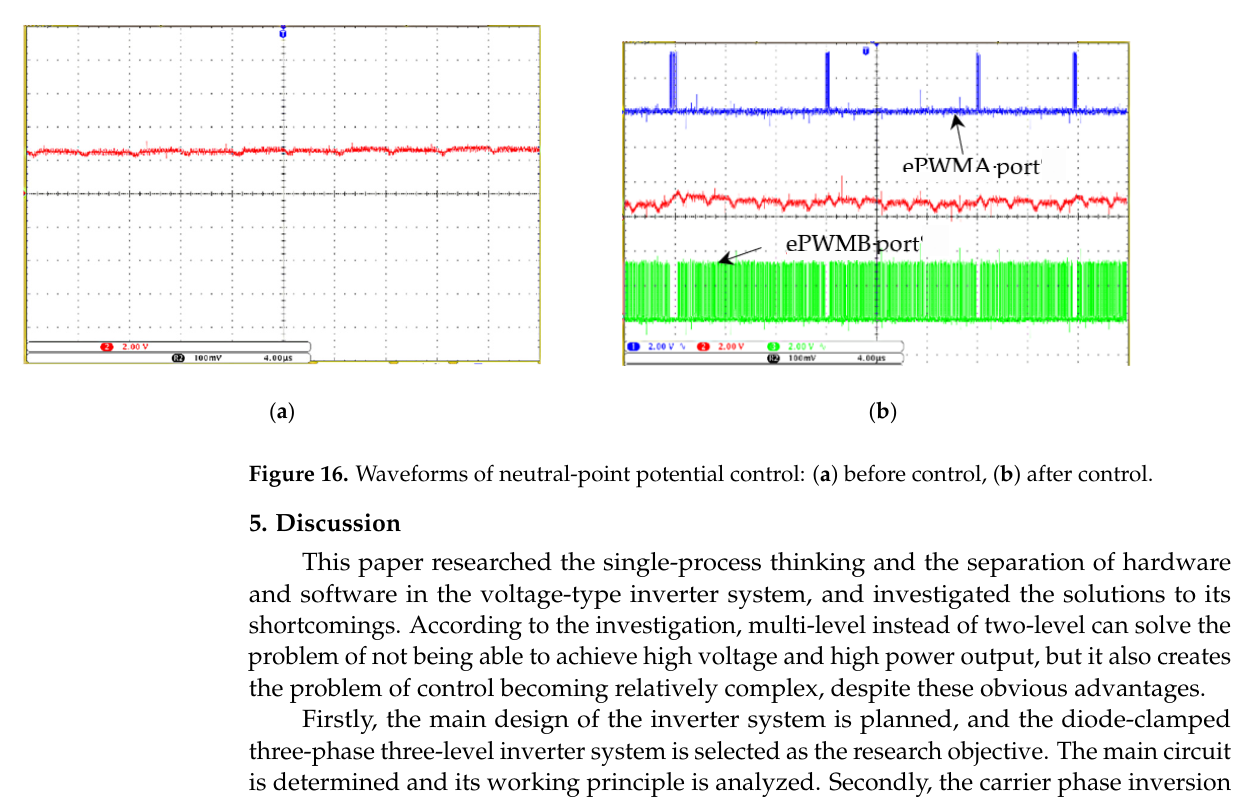
Figure 15. Comparison waveforms of current by regulating frequency: ( a ) before regulating, ( b ) af- ter regulating.